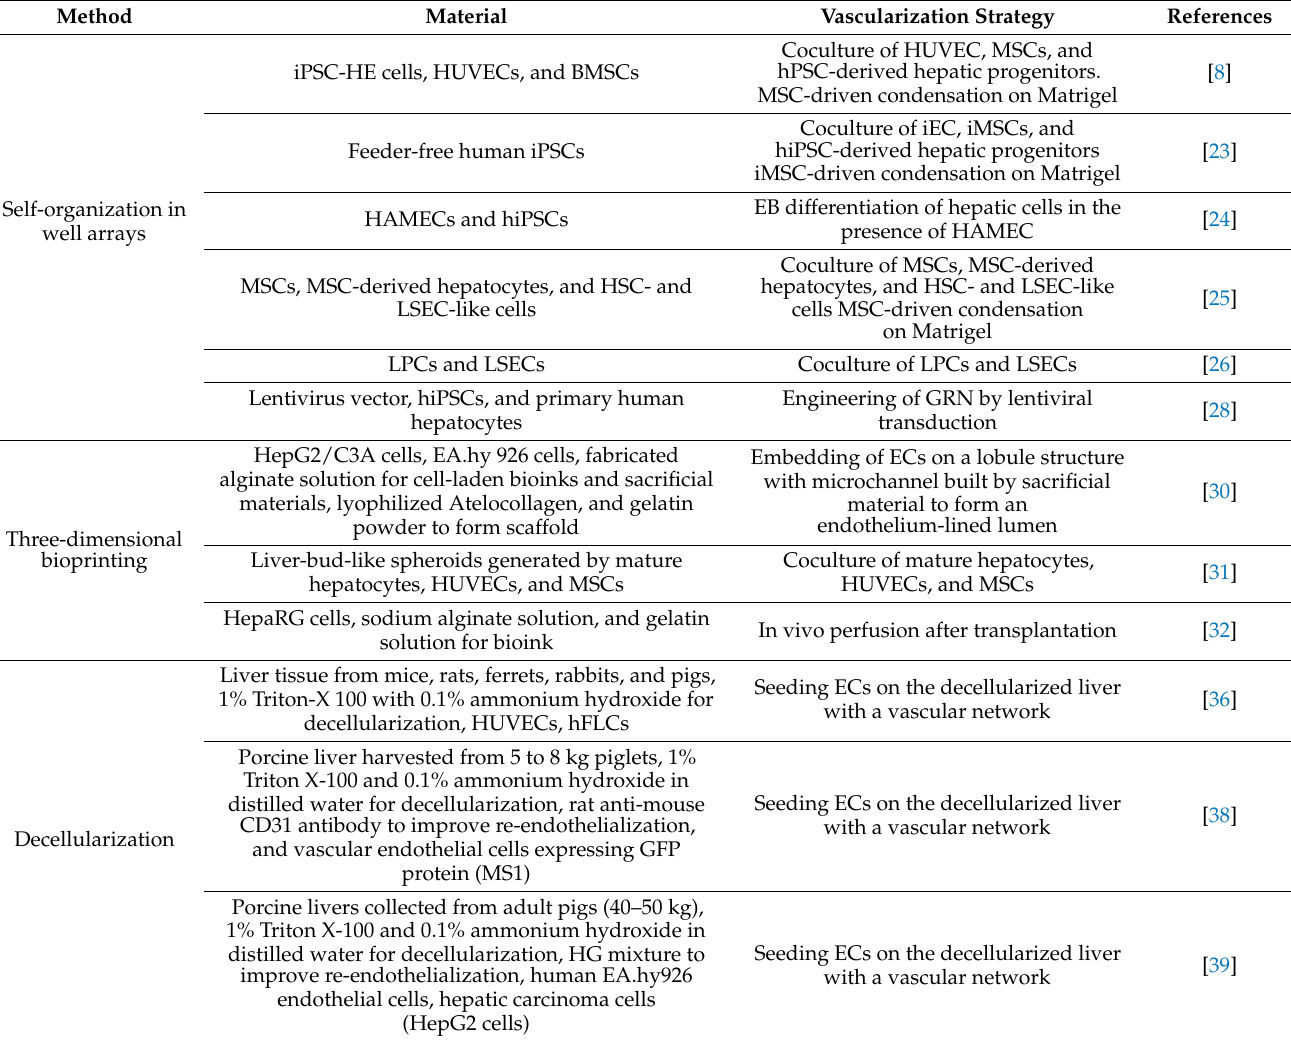
Table 1. Summary of the current published protocols for the vascularization of liver organoids.